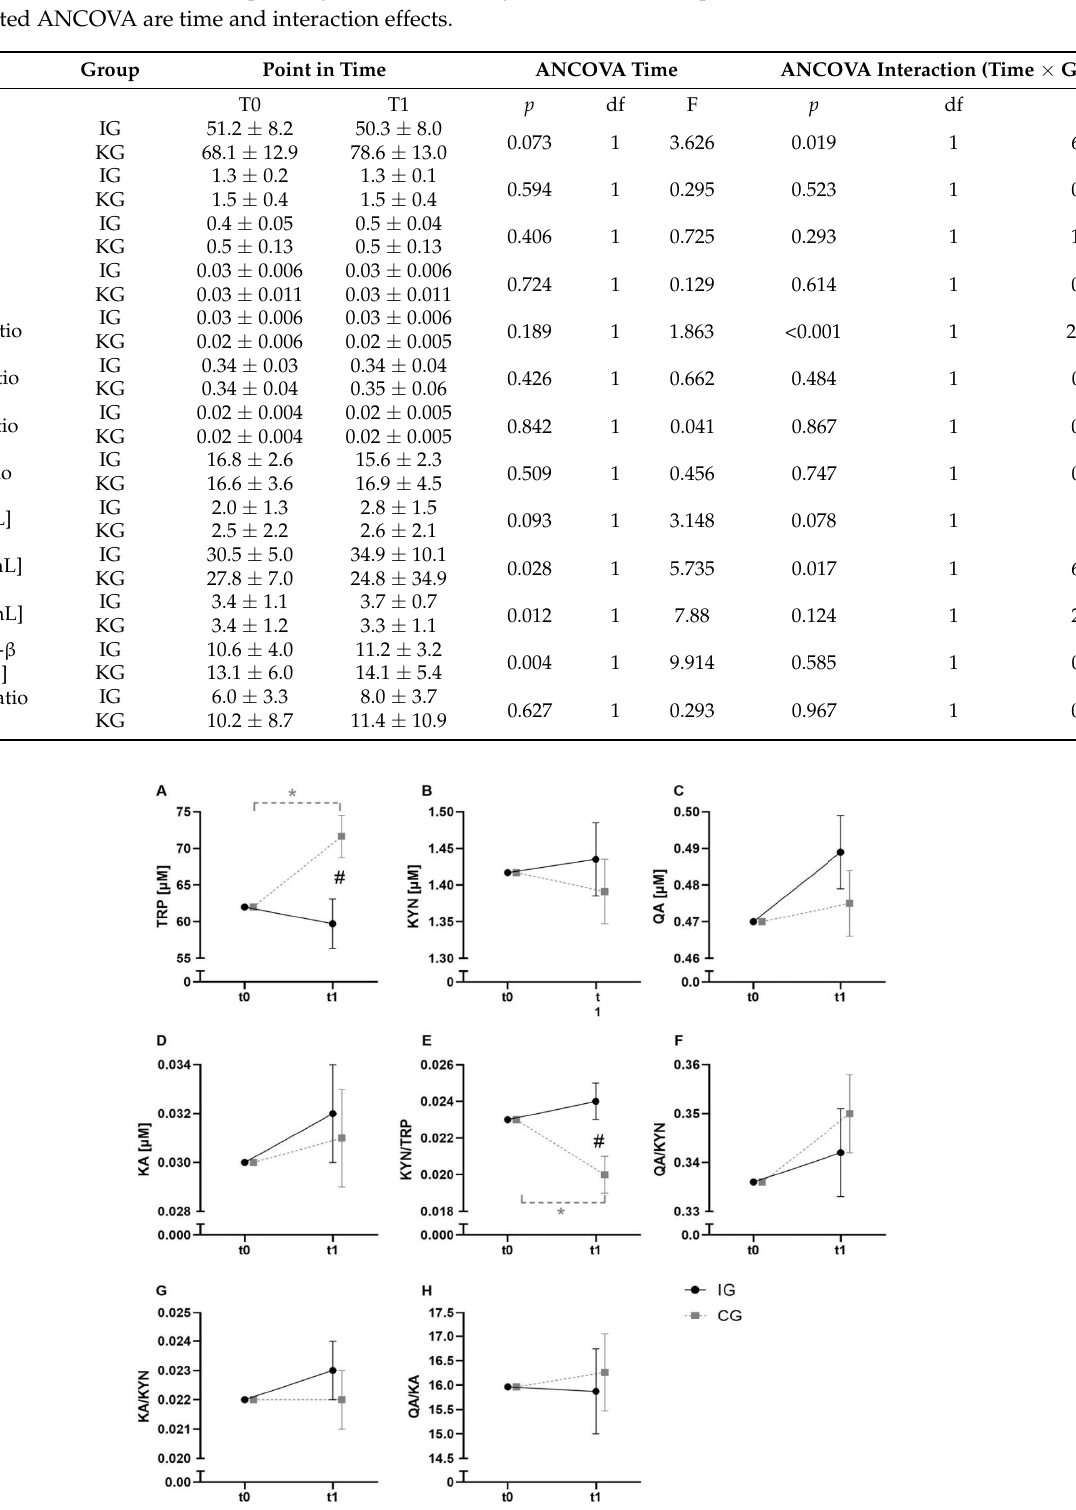
Figure 2. KYN pathway results of the baseline-adjusted ANCOVA. Diagrams show the baseline adjusted serum concentra- tions of the KYN-pathway metabolites TRP ( A ), KYN ( B ), QA ( C ) and KA ( D ). Furthermore, the ratios of KYN/TRP ( E ), QA/KYN ( F ), KA/KYN ( G ) and QA/KA ( H ) are shown.IG is presented in black color and solid lines, whereas CG is in grey and broken lines. Significant post-hoc results for time effects are indicated by an asterisk (*) and for interaction effect by “#”. The significance level was set to α ≤